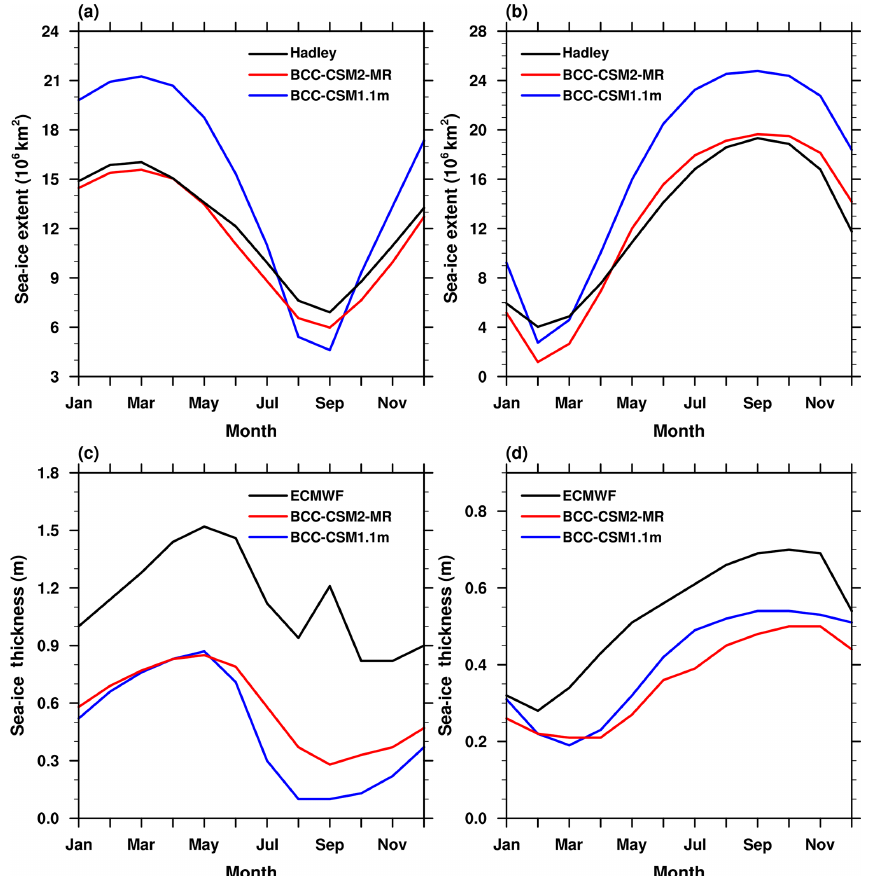
Figure 15. The mean (1980–2005) seasonal cycle of sea-ice extent ( a, b , the ocean area with a sea-ice concentration of at least 15%) and mean thickness (c, d) in the Northern Hemisphere (a, c) and the Southern Hemisphere (b, d) . The observed seasonal cycles of sea-ice extent in (a) and (b) are derived from the 1980 to 2005 Hadley Centre Sea Ice and Sea Surface Temperature data set (Rayner et al., 2003), and the ice thickness in (c, d) are derived from the 1980 to 2005 global gridded data set based on the European Center for Medium-Range Weather Forecast (Tietsche, et al.,